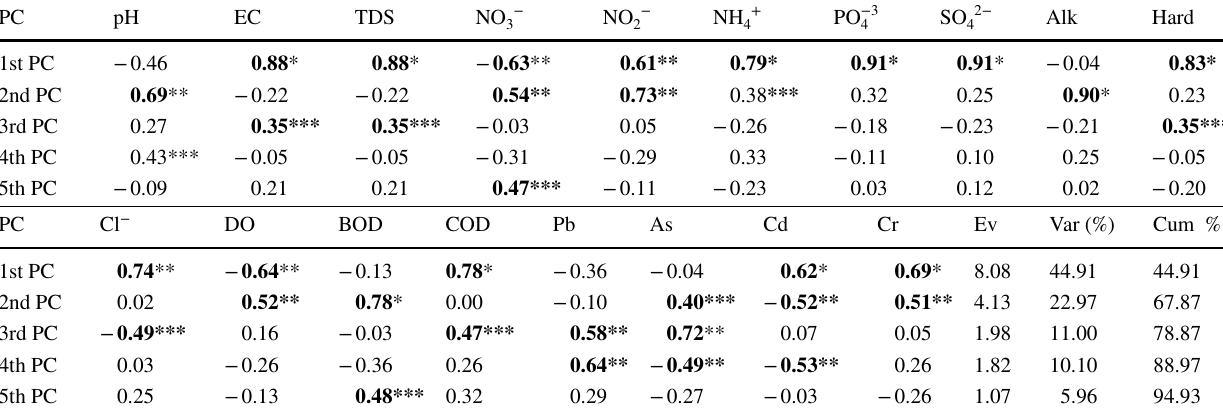
Fig. 4 Dendrogram based on hierarchical clustering (Ward’s method) for seven sampling sites of Gomti River in Lucknow City Table 4 Loadings of 18 variables on principal components for the whole datasets